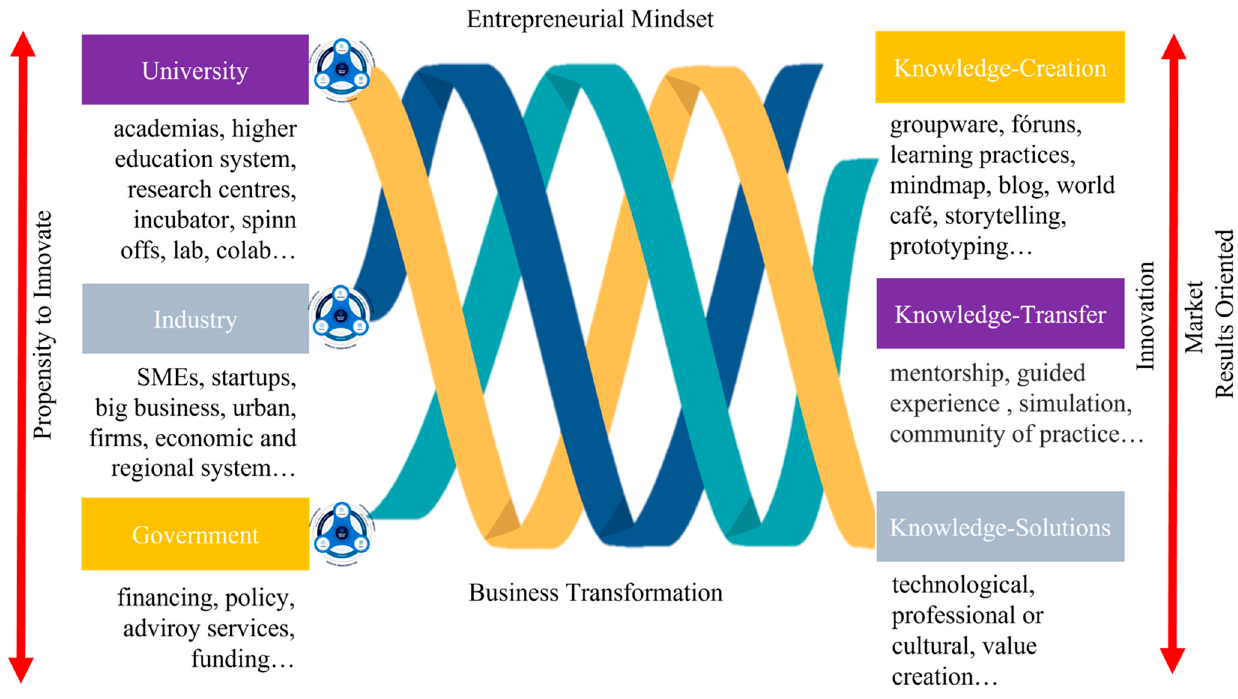
Figure 2. Framework to Integrate the Spinner Innovation and Triple Helix Models. According to the framework, a number of actors, whether one, two or three (Triple Helix), may or may not display the propensity to contribute to the respective innovation.